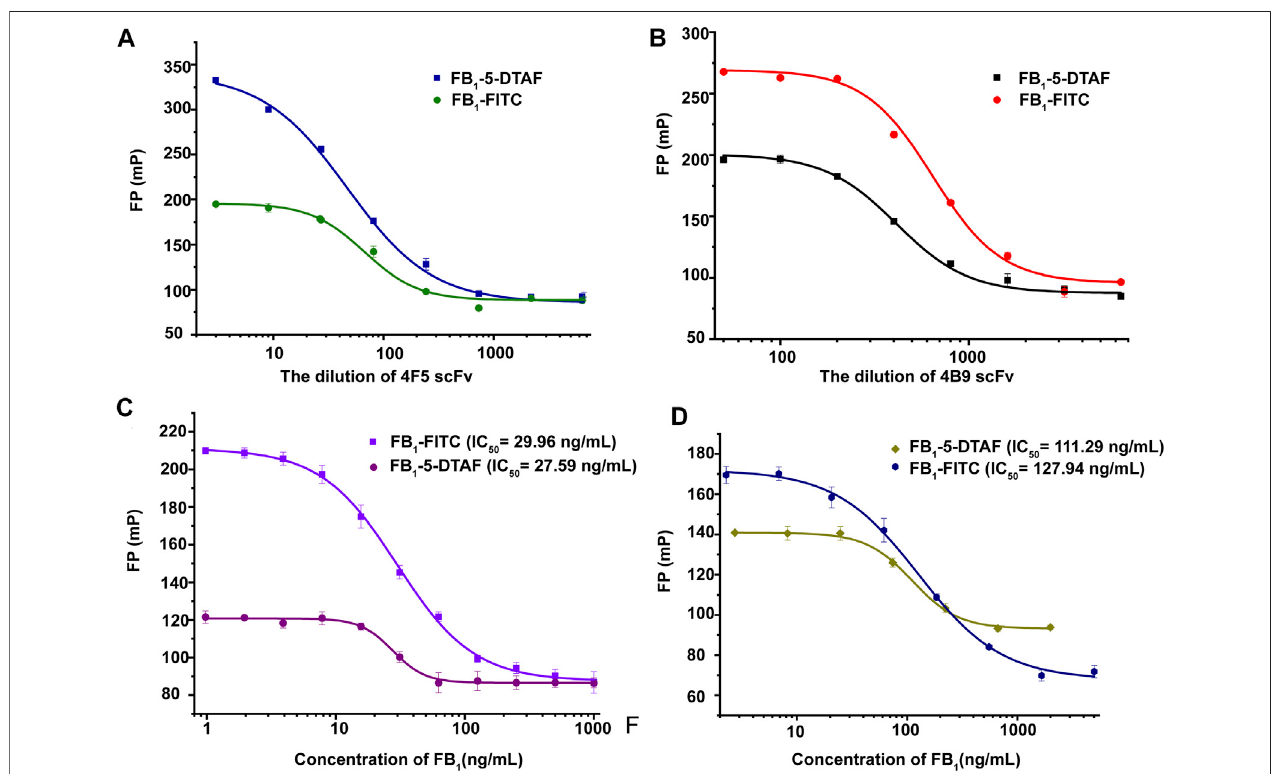
FIGURE 2 | Optimization of scFv and tracer concentrations. (A) : Optimization of 4F5 scFv concentration. (B) : Optimization of 4B9 scFv concentration. (C) : Optimization of the tracer concentrations of with 4F5 scFv. (D) : Optimization of the tracer concentrations with 4B9 scFv.